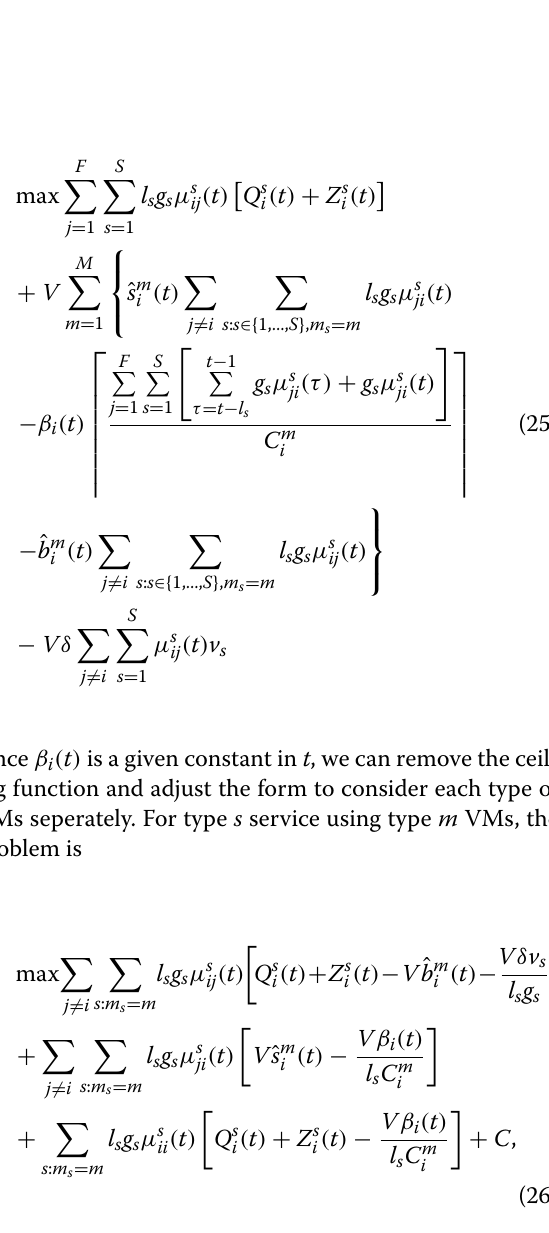
VM valuation and bid